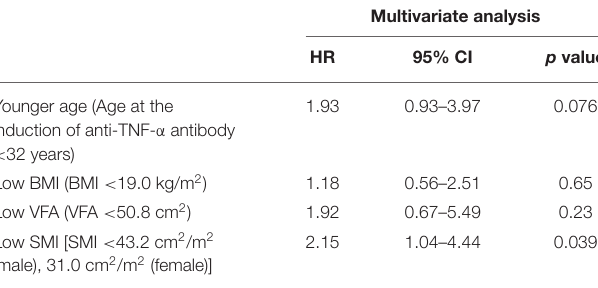
TABLE 2A | Univariate analyses of factors associated with secondary failure during anti-TNF therapy (log rank test).